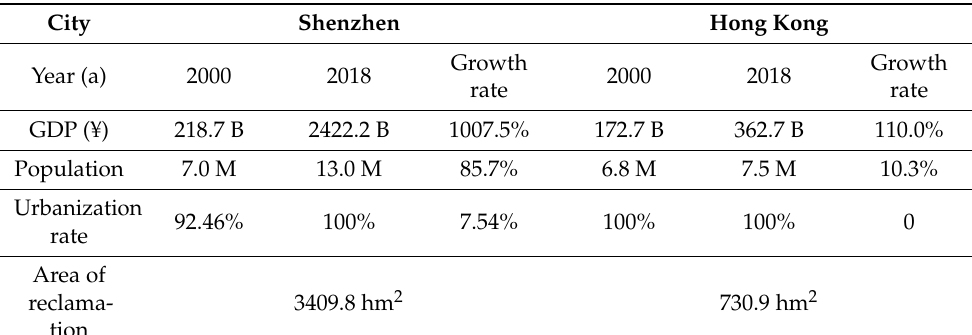
Table 3. GDP, population, and urbanization rate of Shenzhen and Hong Kong in 2000 and 2018, and coastal reclamation area over